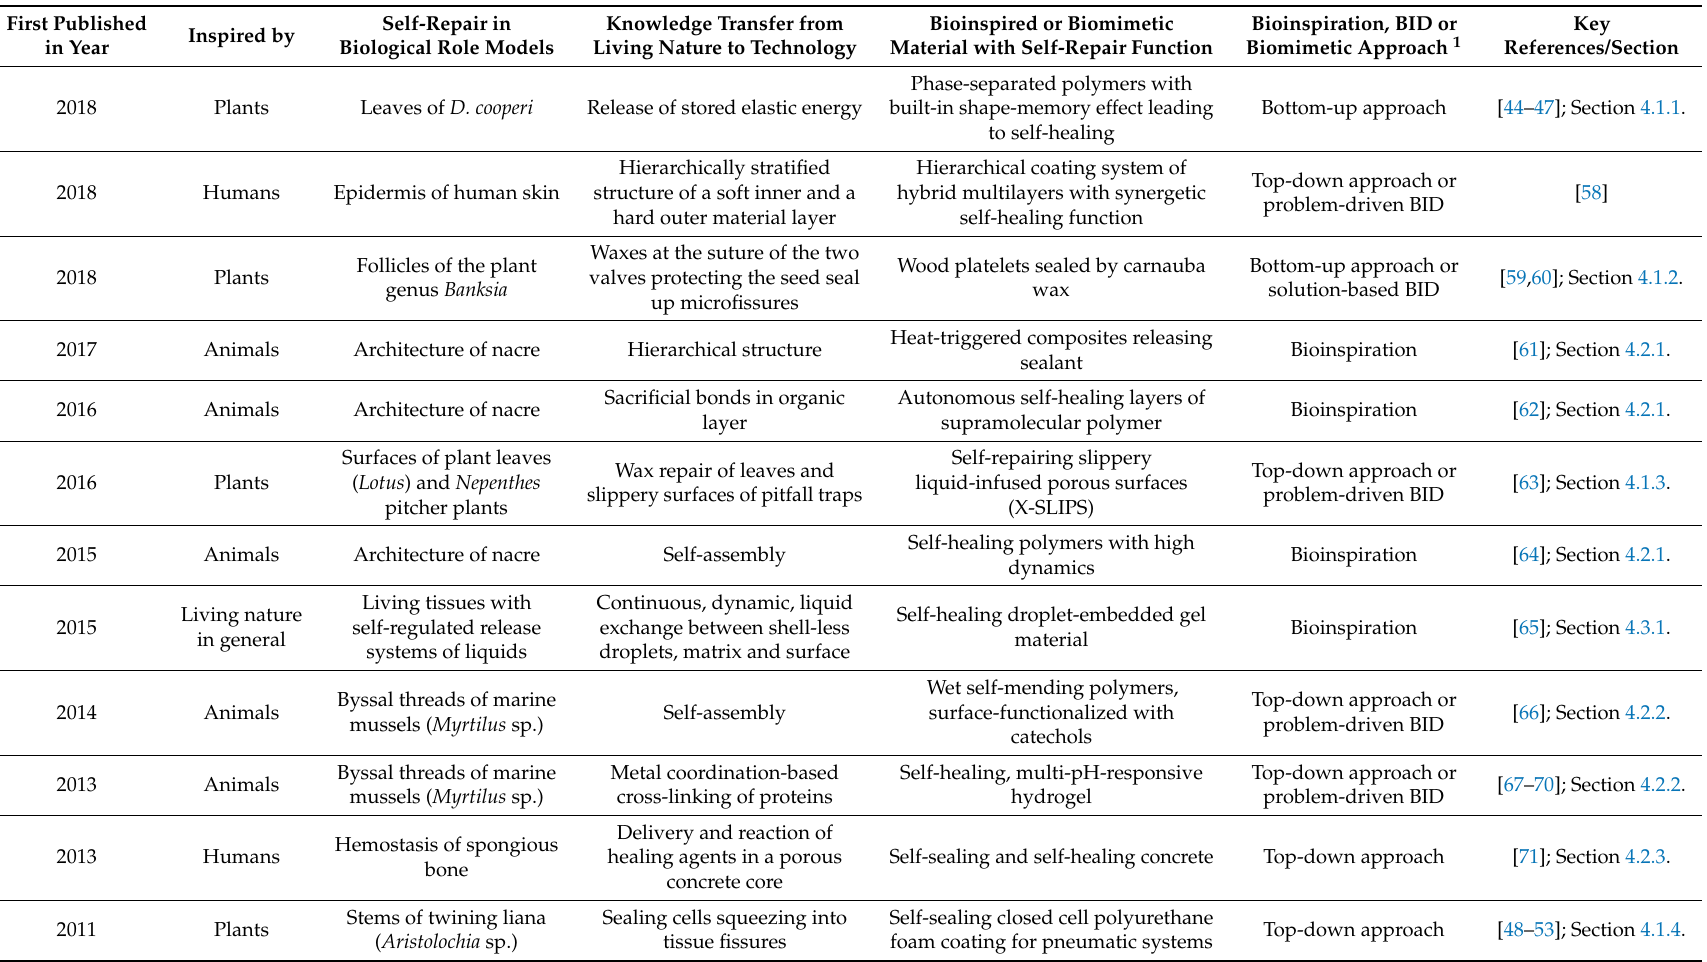
Table 5. Chronological overview of key publications concerning nature-inspired self-repairing